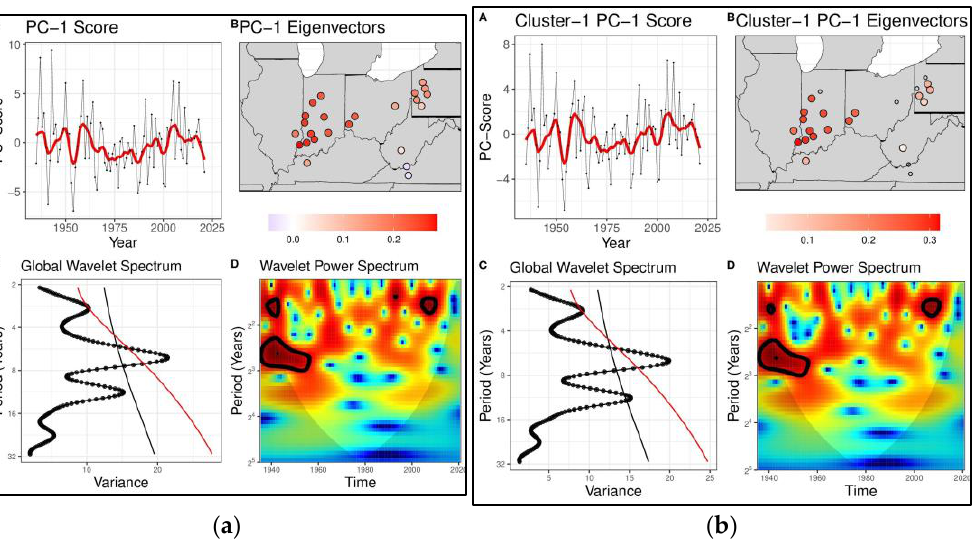
Figure 4. PC-Wavelet analysis (( a )) on the first principal component of the annual maximum stream- flow data. Wave-Clust analysis (( b )) on the leading principal component of the first largest cluster of the annual maximum streamflow. For each subplot: ( A )—The principal component score with the local polynomial regression (7-year span) fit was in red. ( B )—The eigenvectors of the principal component for the associated stream gauges. The color grey denotes stream-gauges not in the cluster for Wave-Clust. ( C )—Global wavelet spectrum of the principal component score. The red and black lines correspond to the 90% significance level for red and white noise, respectively. ( D )— Wavelet power spectrum of the principal component score. The regions bounded in thick contour line are significant.